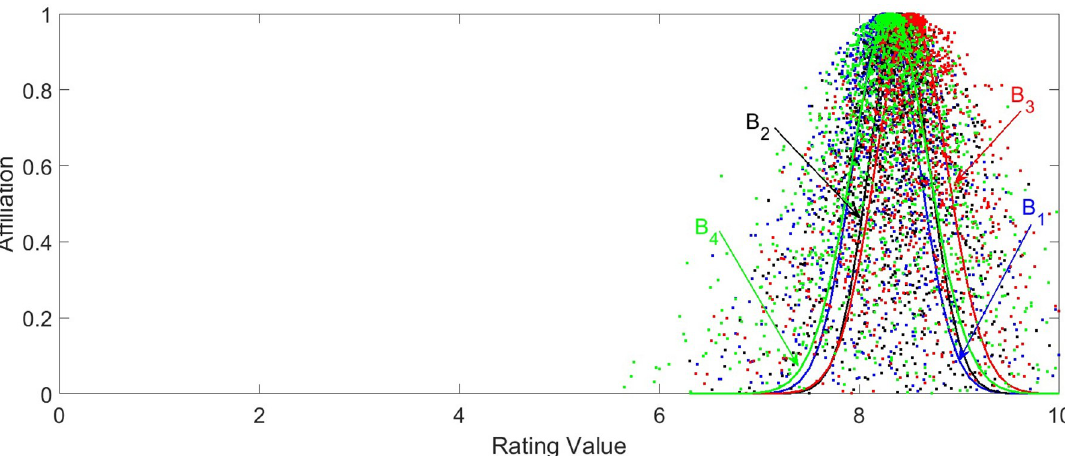
Fig 6. Cloud diagram of first-class indexes. The blue color indicates the cloud diagram of noise and vibration. The black color indicates the cloud diagram of light environment. The red color indicates the cloud diagram of thermal environment. And the green color indicates the cloud diagram of human-computer